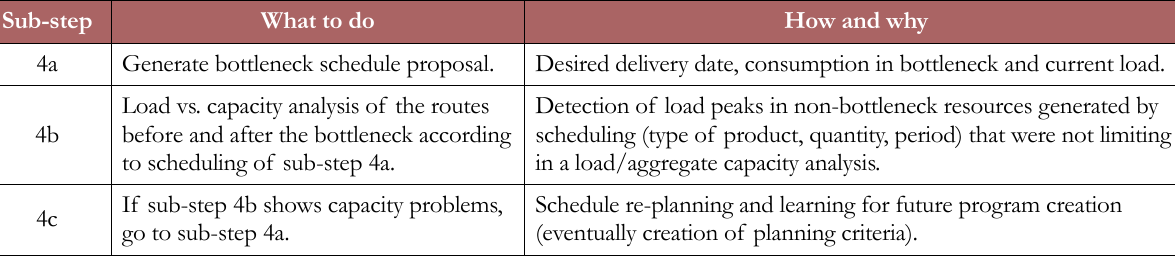
Table 7. Operative sub-steps to exploit the